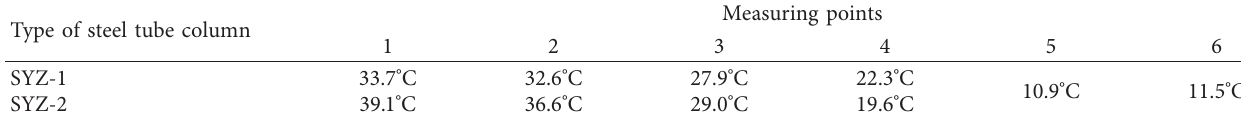
Table 3: Maximum values of temperature at each measuring point of the core concrete.